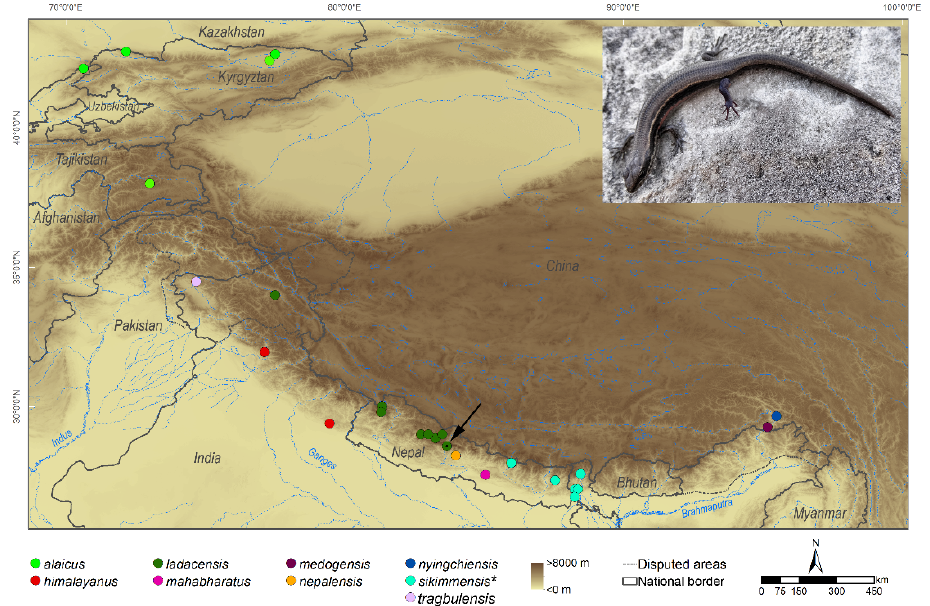
Figure 1. Map of Asymblepharus species based on GBIF (www.gbif.org; accessed on 20 July 2021) records of preserved specimens and georeferenced localities in the taxonomic reptile database (https://reptile-database.reptarium.cz/; accessed on 20 July 2021). The location of our RNA sample of the female A. ladacensis (photo) is indicated by a green circle with a dot in the middle and an arrow. *Note, according to a large-scale phylogeny of squamates, A. sikimmensis is nested within Scincella ; however, it remains unclear whether this single “ A. sikimmensis ” specimen, on which the sequence data are based, had been taxonomically correctly identified. Therefore, we also show the GBIF records of specimens collected as A. sikimmensis . Records of A. eremchenkoi in the databases could not be georeferenced due to insufficient information on the collection site. Photo credit: Sylvia Hofmann.